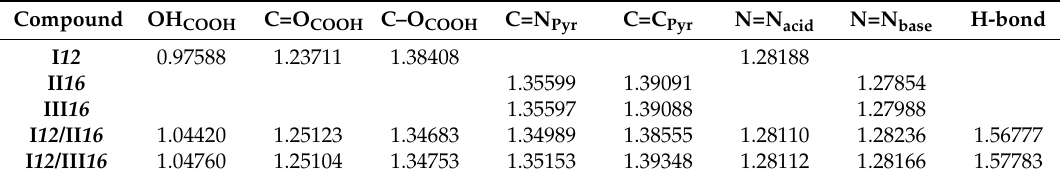
Table 3. The calculated geometric bond length in Å of characteristic groups of I 12 , II 16 , III 16, I 12 /II 16 and I 12 /III 16 .